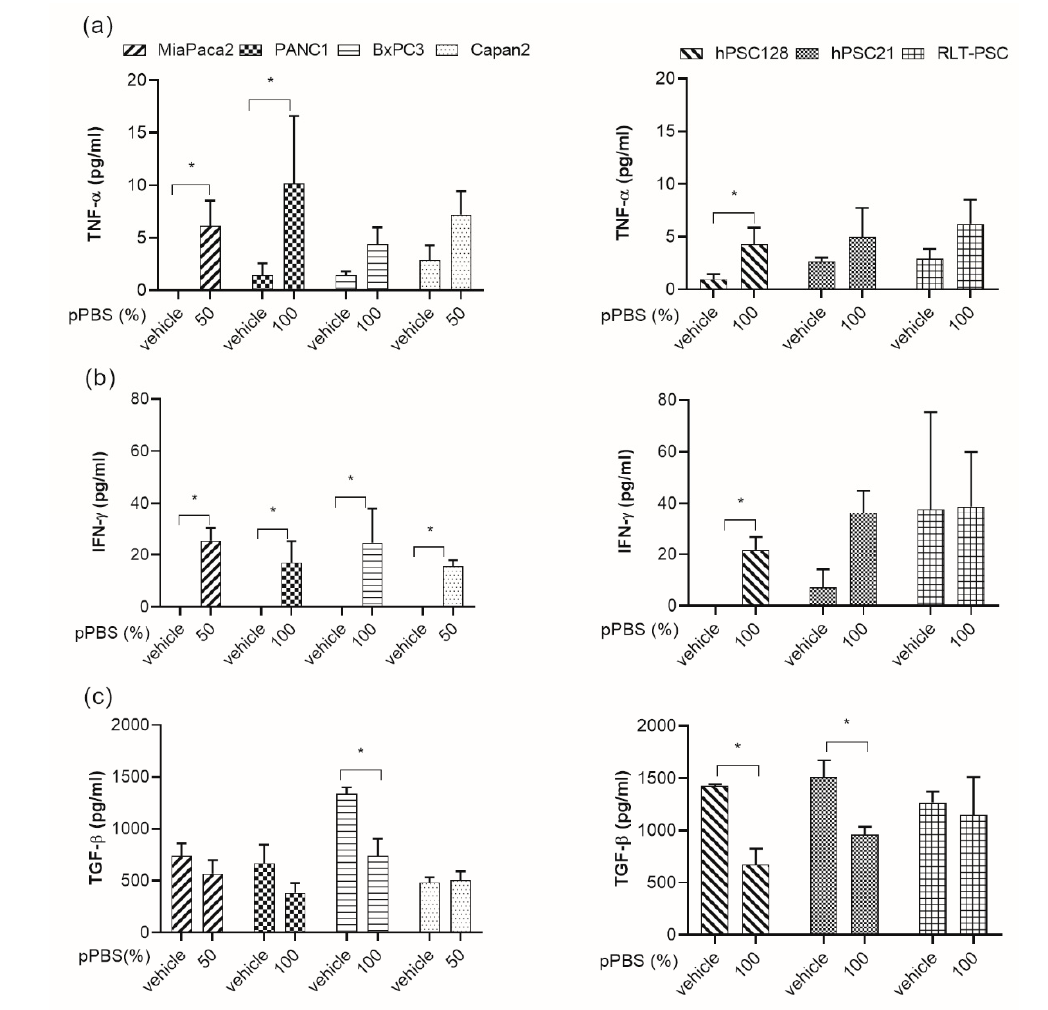
Figure 5. Cytokine profile released by DCs in coculture with pPBS-treated PCCs and PSCs. Graphs show the concentration of TNF- α ( a ), IFN- γ ( b ), and TGF- β ( c ) released in coculture of DCs with pPBS-treated PCCs (left) and PSCs (right) after 48 h. Graphs represent mean of ± SEM of ≥ 3 independent experiments with different donors. * p < 0.05 significant differences compared with untreated control.